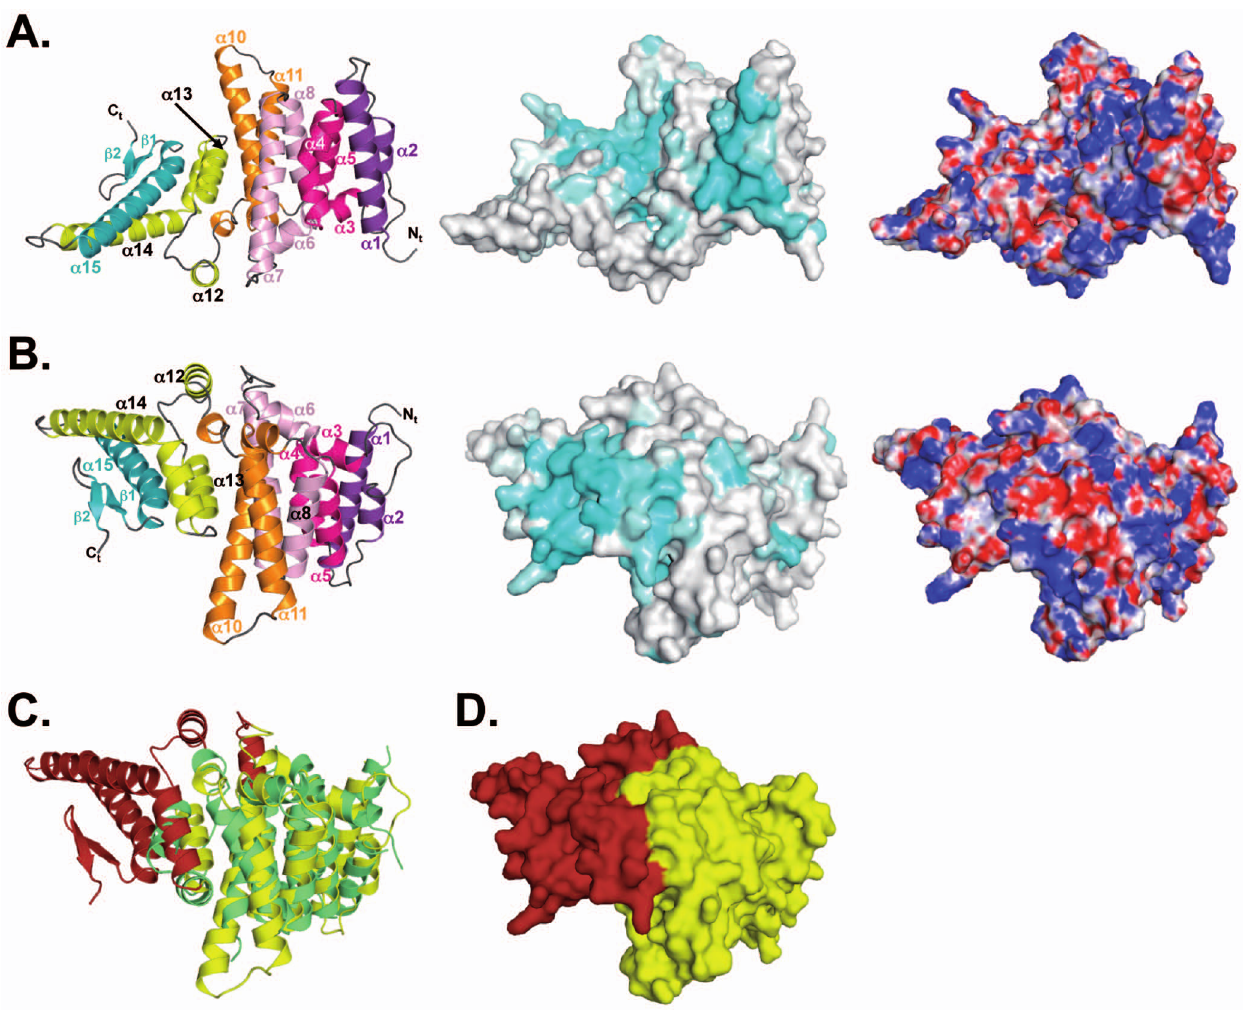
Figure 1. Structure of S.cerevisiae Pat1 C domain. A and B. Left panels: ribbon representation of ScPat1C crystal structure. The ARM repeats are depicted using different colors. Middle panel: Mapping of the sequence conservation at the surface of the ScPat1C domain. Coloring is from grey (low conservation) to cyan (highly conserved). The conservation score was calculated using the CONSURF server [67] and using an alignment made from the sequences of 30 Pat1 fungal orthologues. Right panel: Mapping of the electrostatic potential at the surface of the ScPat1C domain. Positively (10 k B T/e - ) and negatively ( 2 10 k B T/e - ) charged regions are colored in blue and red, respectively. The electrostatic potential was calculated using PBEQ Solver server [68]. Orientation in B differs from A by a 180 u rotation along the horizontal axis. C. Ribbon representation of the superimposition between human Pat1C domain (green; [36]) and ScPat1C domain. The core conserved from yeast to human is colored in yellow. The fungi specific C- terminal extension from ScPat1C is colored in red. D. Surface representation of ScPat1 domain. Same color code as panel